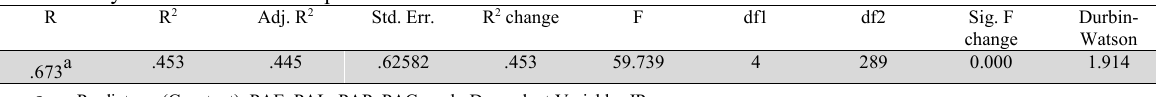
The summary of the results of R-Square value and Durbin-Watson